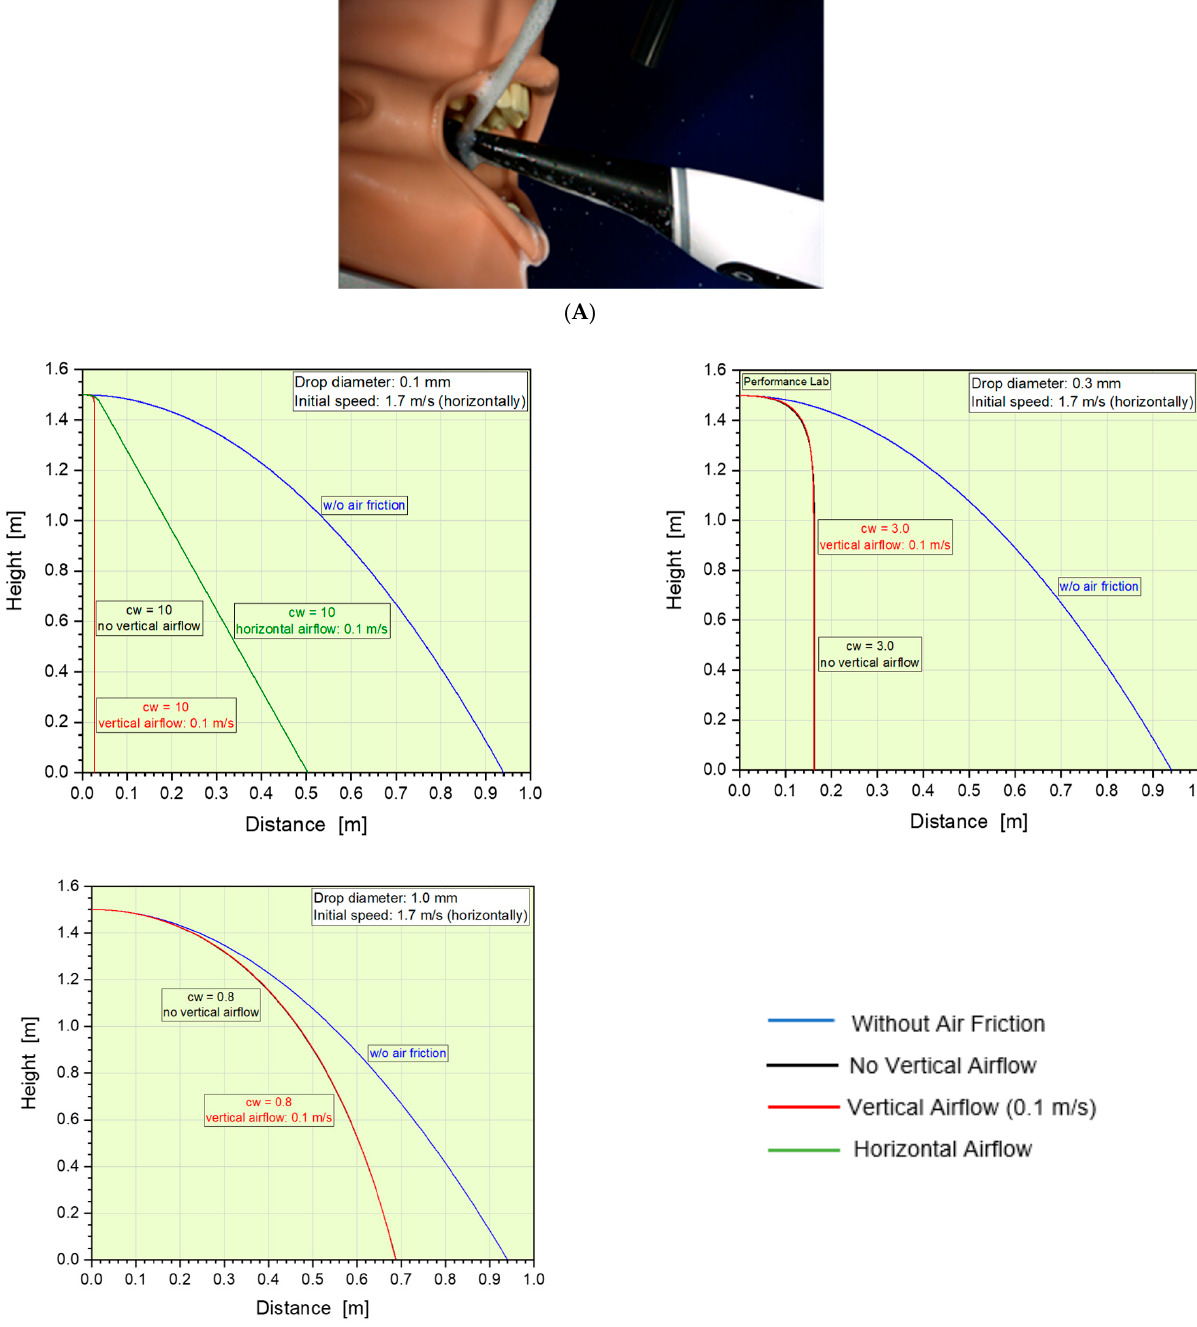
Figure 5. ( A ) High-speed video (still image) of particle emission with operator brushing mannequin. ( B ) Visualization of droplet trajectories of various droplet sizes. Table 2. Droplet trajectories for various droplet sizes *.